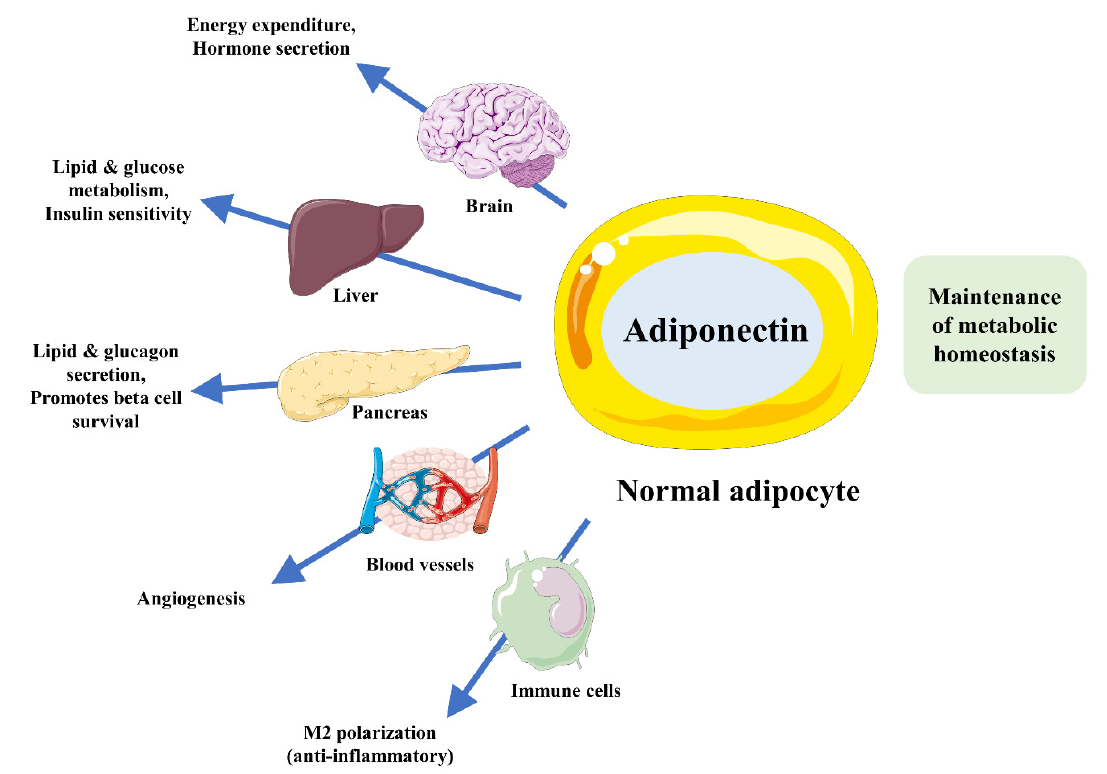
Figure 1. Major mechanisms of adiponectin’s actions in the maintenance of metabolic homeostasis.